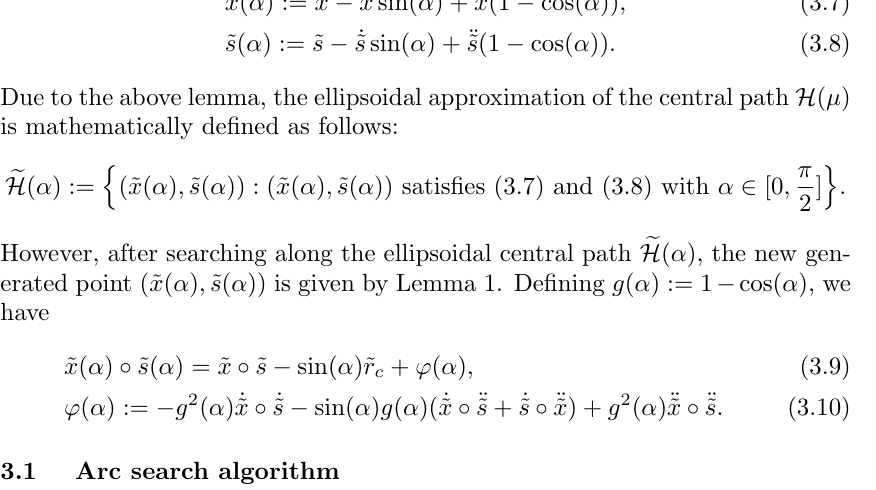
Algorithm 1. (Arc search feasible interior-point algorithm for monotone